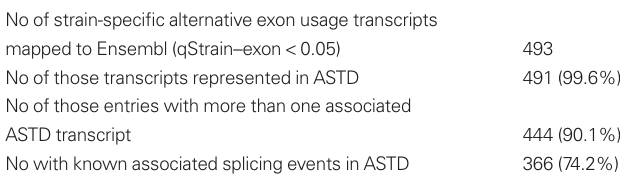
Table 1 | Concordance of putative Aeu of probeset model with public domain data from